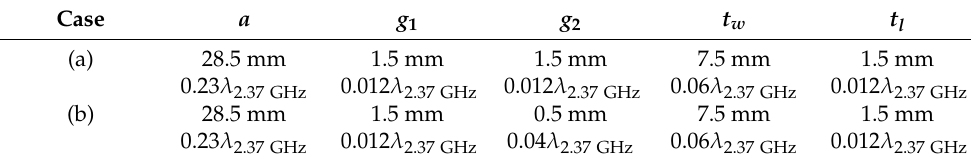
Table 2. Dimensions used for UCPBG and HCPBG designs.